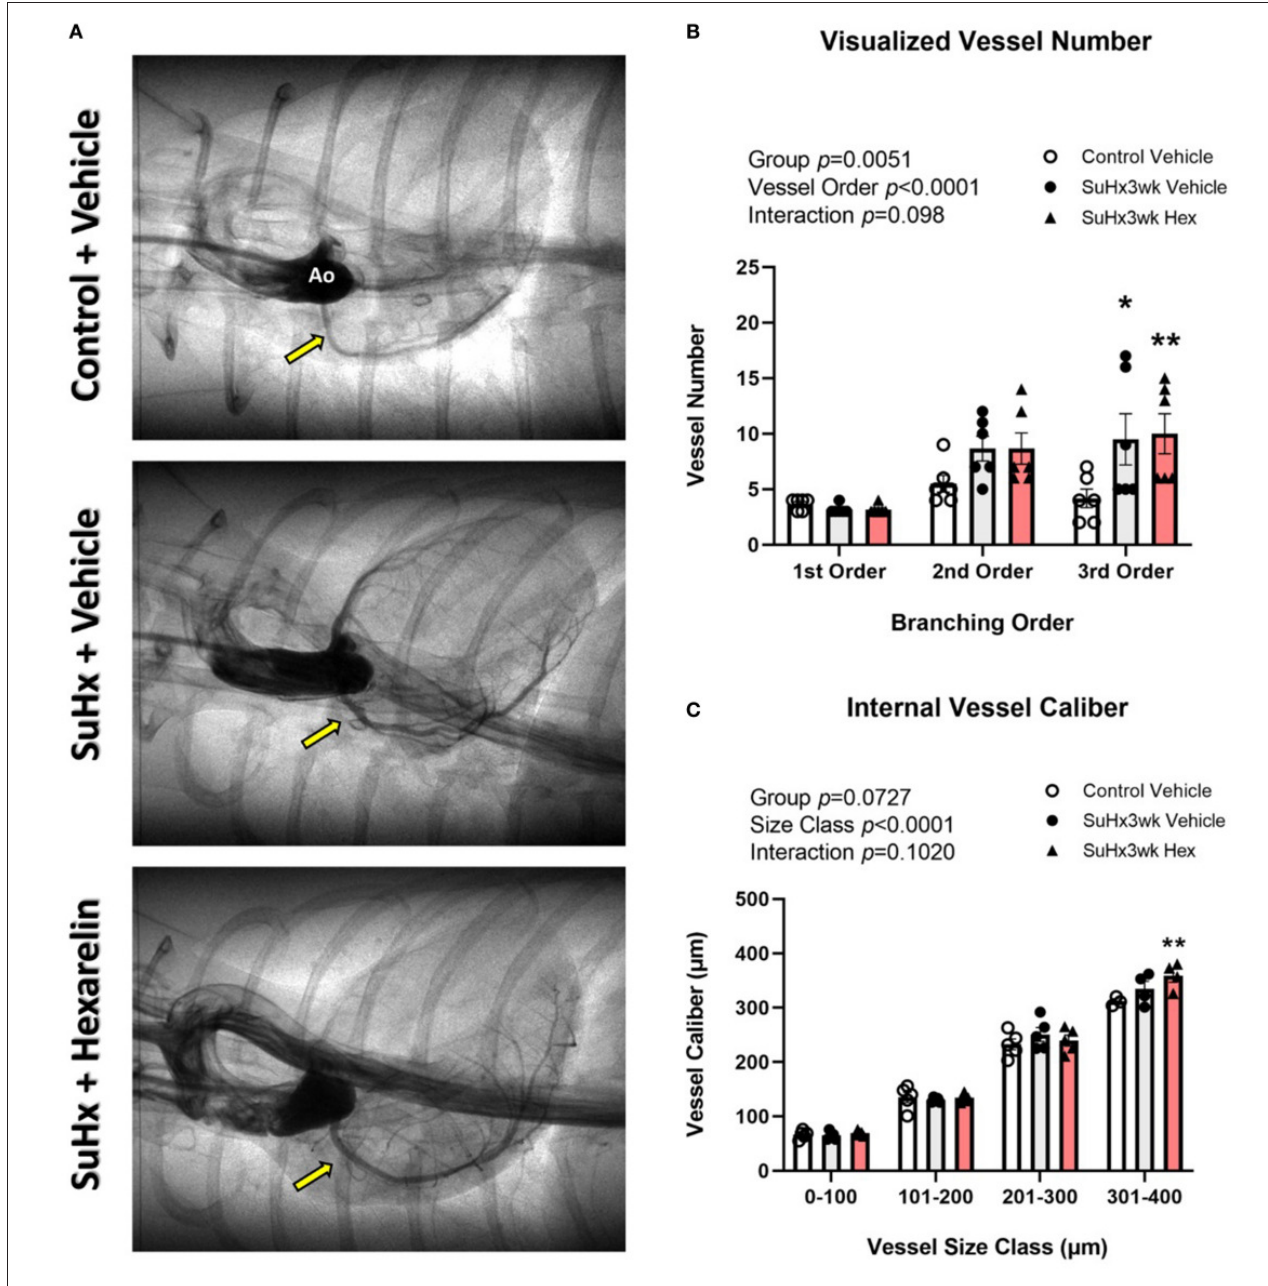
FIGURE 4 | Assessment of right coronary perfusion in the control ( n = 7), SuHx3wk vehicle ( n = 7), and SuHx3wk hex ( n = 7) rats. (A) Representative images of the right coronary circulation for the three treatment groups. (B) Visible vessel number across the right coronary vascular network as categorized by vessel branching order. When compared to the control vehicle rats, both the groups of SuHx3wk rats had a similar number of 1st order vessels, but second and third order vessel numbers were greater in the SuHx3wk rat groups than in the control vehicle rats. (C) Vessel caliber measurements. Vessel caliber was significantly different between the various vessel size classes ( C , p < 0.0001), and significantly increased ( p < 0.01) in the SuHx3wk hex-treated rats compared to control in the 301–400 µ m vessel size class (C) ; however, no other significant changes were observed between the groups at any other vessel size class. A two-way ANOVA was performed to compare differences followed by Bonferroni’s post hoc test to establish within group differences. * p < 0.05, ** p < 0.01 vs control vehicle. Data are expressed as mean ± standard error of the mean (SEM).